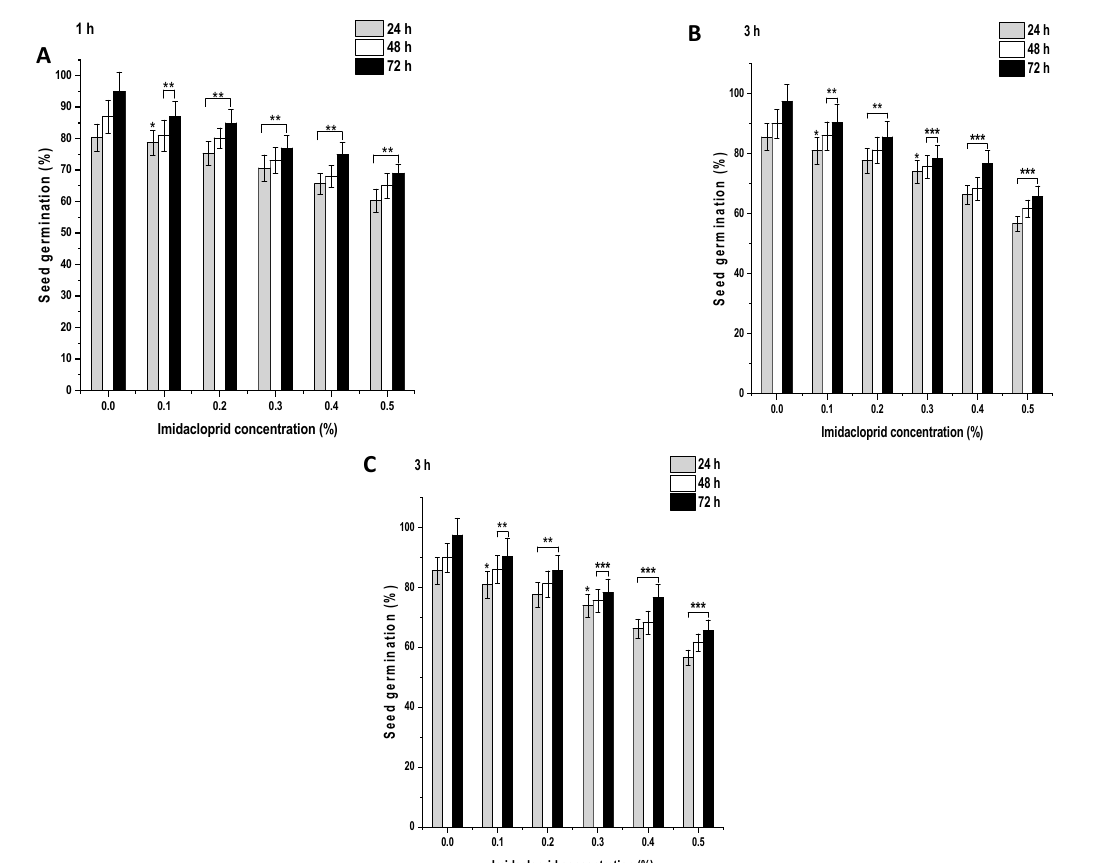
Figure 2. Seed germination (SG) in P. sativum seeds exposed to methomyl (ME) for ( A ) 1 h, ( B ) 3 h and ( C ) 6 h at 24, 48, and 72 h after exposure. Data represent mean and SE. The experiment was